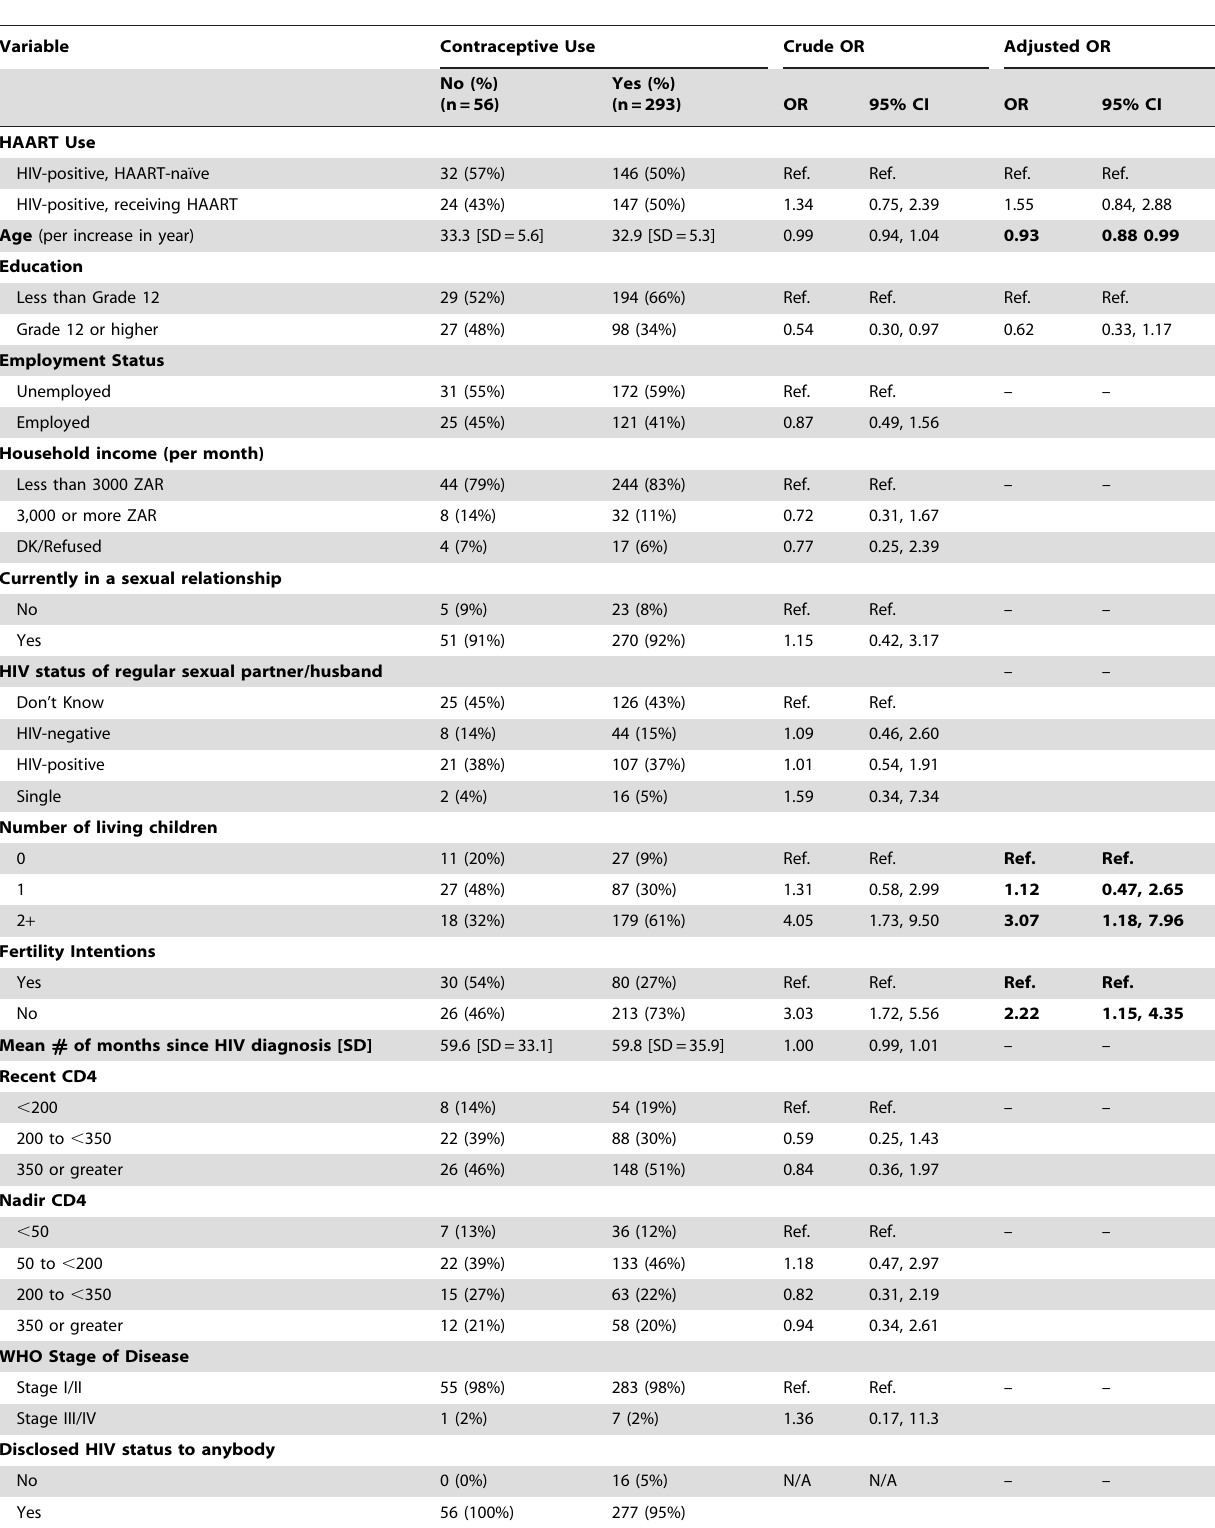
Table 4. Univariate and adjusted analyses of variables associated with contraceptive use among HIV-positive women (aged 18–44 years, currently sexually active and non-pregnant) in Soweto, South Africa